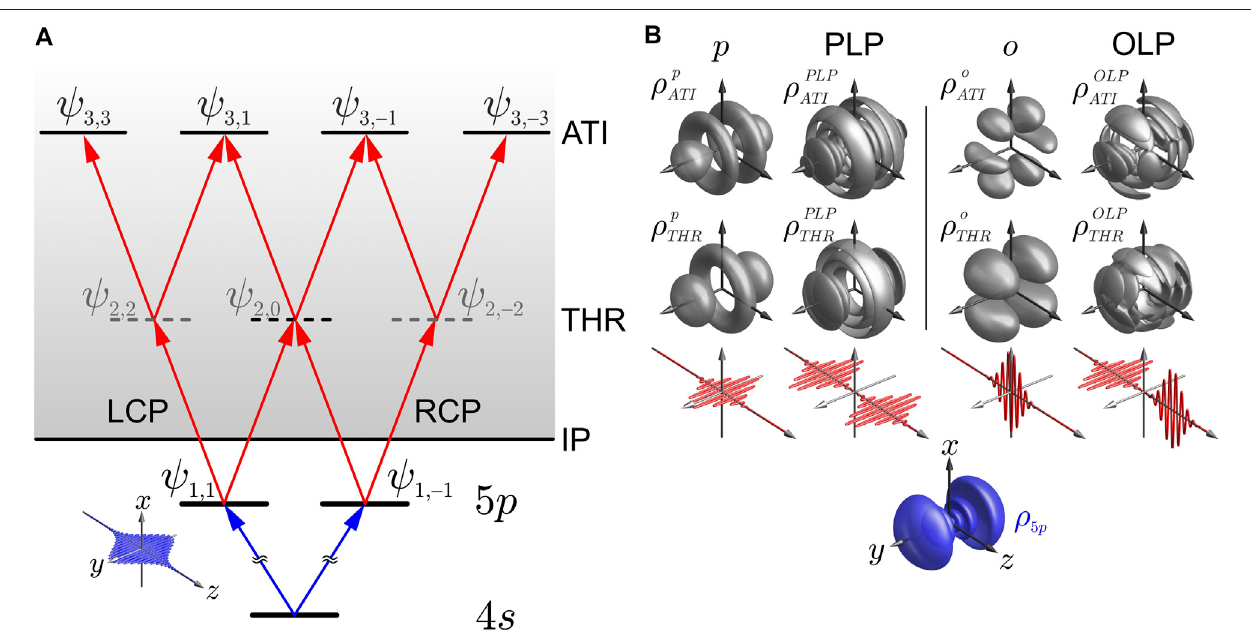
FIGURE 5 | One- and two-photon ionization of potassium atoms with an infrared PLP or OLP pulse sequence after preparation of the atom in the excited 5 p state by ablue prepulse. (A) Energy level diagram for excitation and ionization in the spherical basis. (B) Simulated electron densities of the excited 5 p state (bottom) and the emitted photoelectron at the threshold (middle row) and ATI (top row) . Left side of each column: Single pulse ionization at the threshold and the ATI for parallel ρ p THR ( ρ p ATI )and orthogonal ρ o THR ( ρ o ATI )polarizedpulses, respectively. Rightside ofeach column: Doublepulse ionizationat thethreshold(ATI) forPLP ρ PLP THR ( ρ PLP ATI ) and OLP ρ OLP ρ OLP THR ( ATI ) pulse